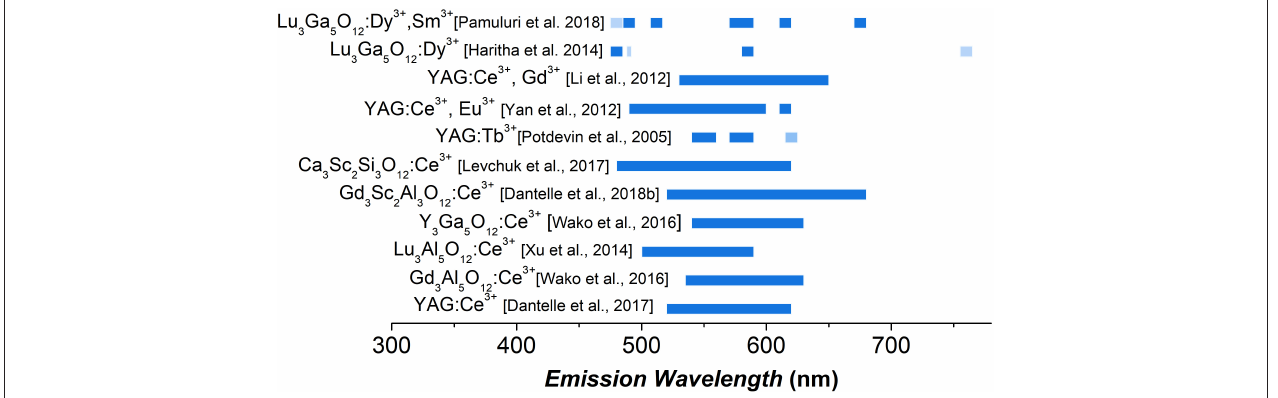
FIGURE 2 | Emission range of different garnet-type nanophosphors reported in the literature. The emission range has been defined by considering all emission whose intensity is larger than Imax/2, with Imax the maximal PL emission intensity. The dark blue indicates a strong emission intensity, in comparison to the light blue. No emission intensity comparison can be done among the different